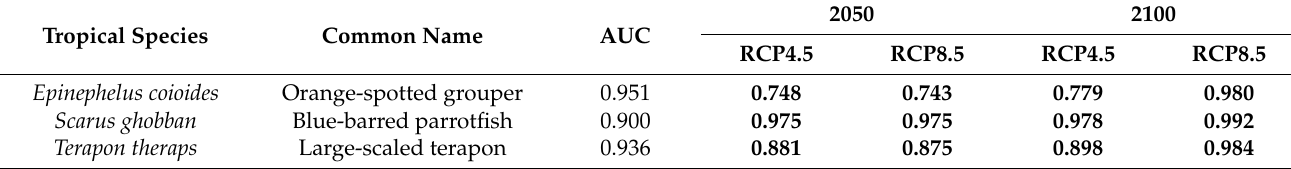
Table 4. Mean R values in the GSA17 for the three tropical species already recorded in the Mediter- ranean Sea. AUC (Area Under the Curve) metric was used to test for model performance according to the scale proposed by Hosmer and Lemeshow (1989): <0.5 = none; 0.5–0.7 = poor; 0.7–0.8 = acceptable; 0.8–0.9 = excellent; >0.9 = outstanding. Values in bold highlight when the difference between present and future habitat suitability was significant (Wilcoxon test, p <